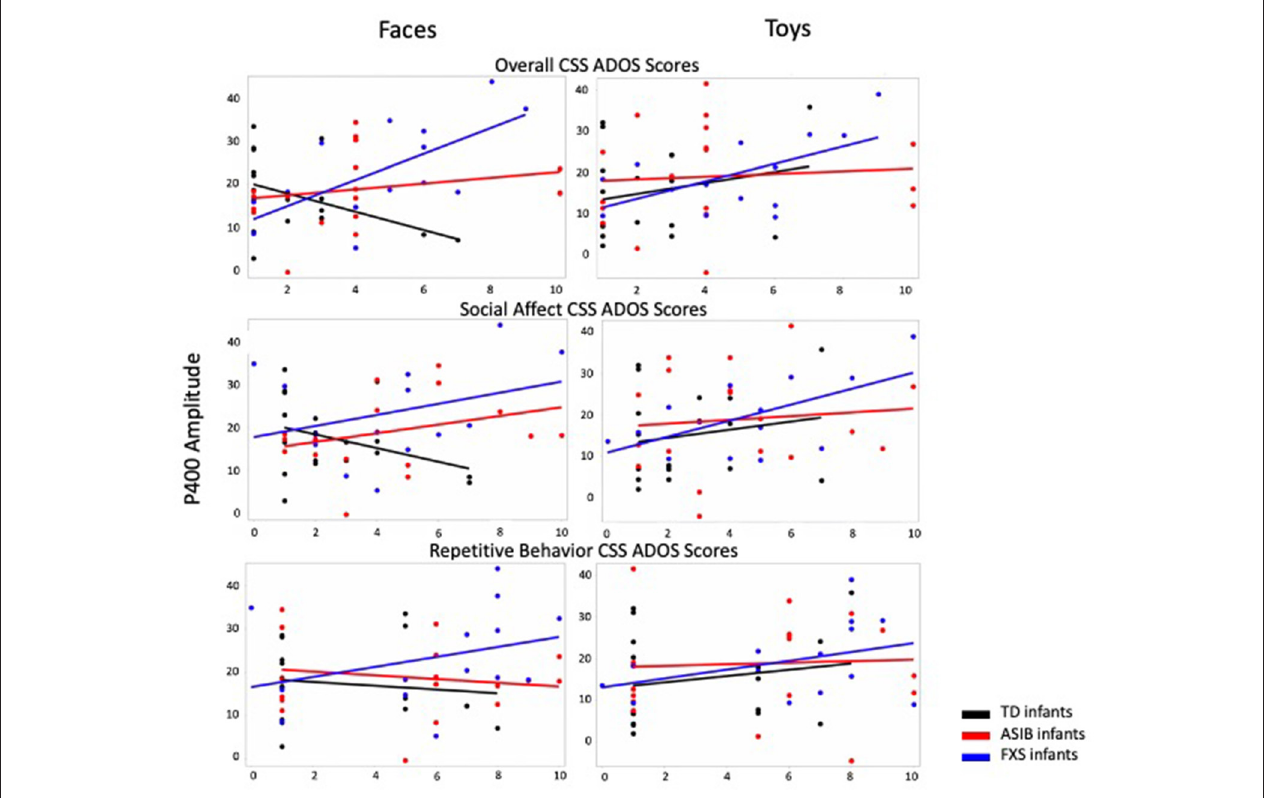
FIGURE 3 | P400 amplitude to faces and toys across ASIBs, infants with FXS, and LRC infants is presented in relation to Overall, Social Affect, and Restricted and Repetitive Behavior calibrated severity scores. Average P400 amplitude is calculated across Parietal Occipital, Occipital, and Inion electrodes.